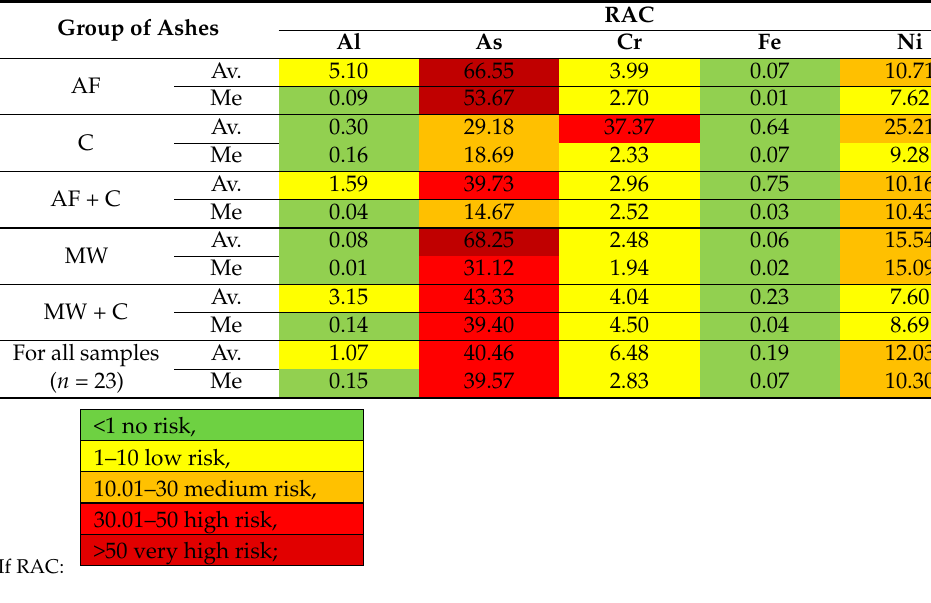
Table 5. Risk assessment code (RAC) values calculated for household ashes. Group of Ashes